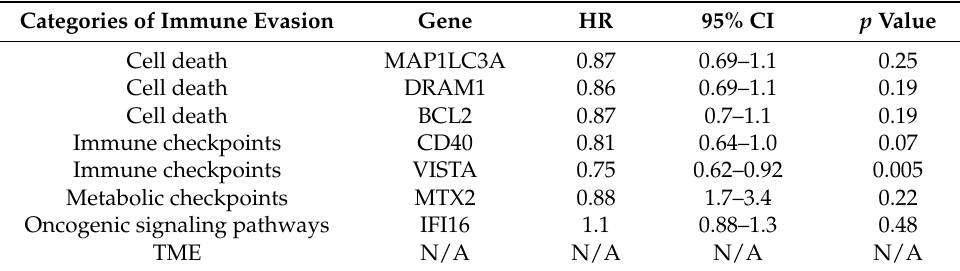
Table 4. Cox regression analysis for OS per individual gene in CoMMpass database.